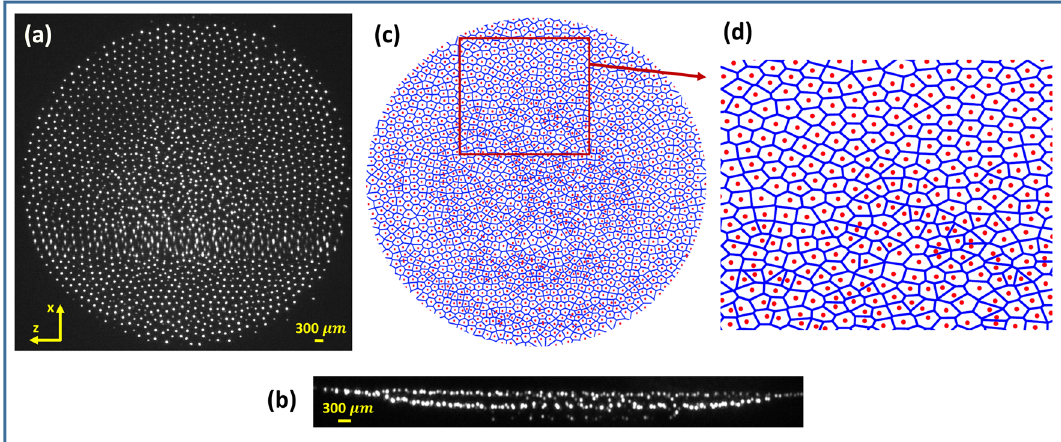
Figure 2. ( a ) Top and ( b ) side view of the phase coexisting complex plasma system. ( c ) Corresponding Voronoi Diagram of ( a ). ( d ) Zoomed view of phase coexisting boundary